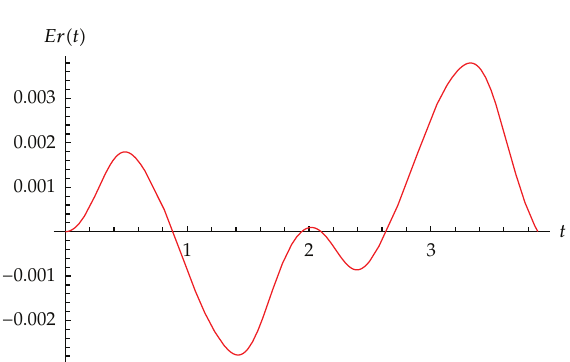
Figure 3: The error between the numerical and approximate solution (cid:2) 2.34 (cid:3) in Case a: a (cid:9) b (cid:9) A (cid:9) 1.